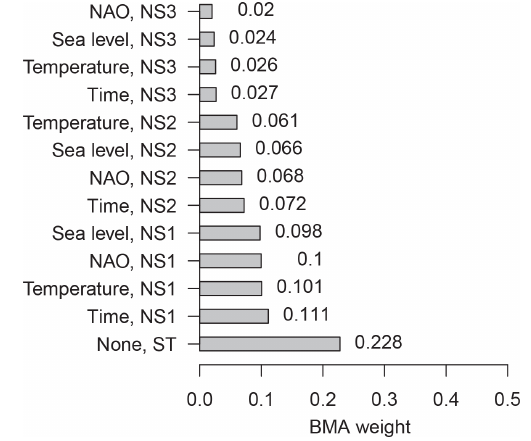
Figure 3. Bar plot showing the Bayesian model averaging weights for each of the 13 distinct candidate model structures, when all are simultaneously